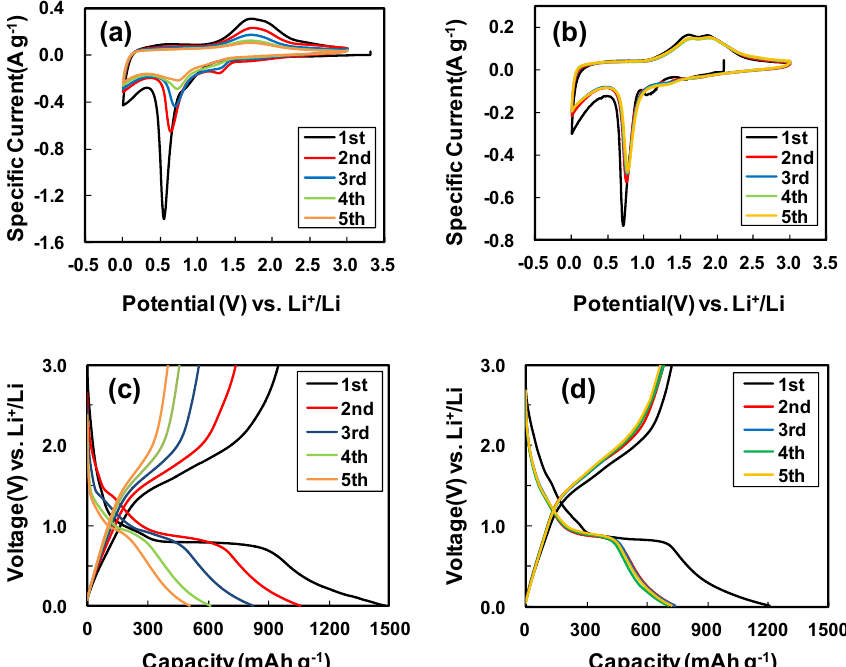
Figure 5. Cyclic voltammetry (CV) curves of ( a ) Fe O and ( d ) Fe of ( c ) Fe 3 4